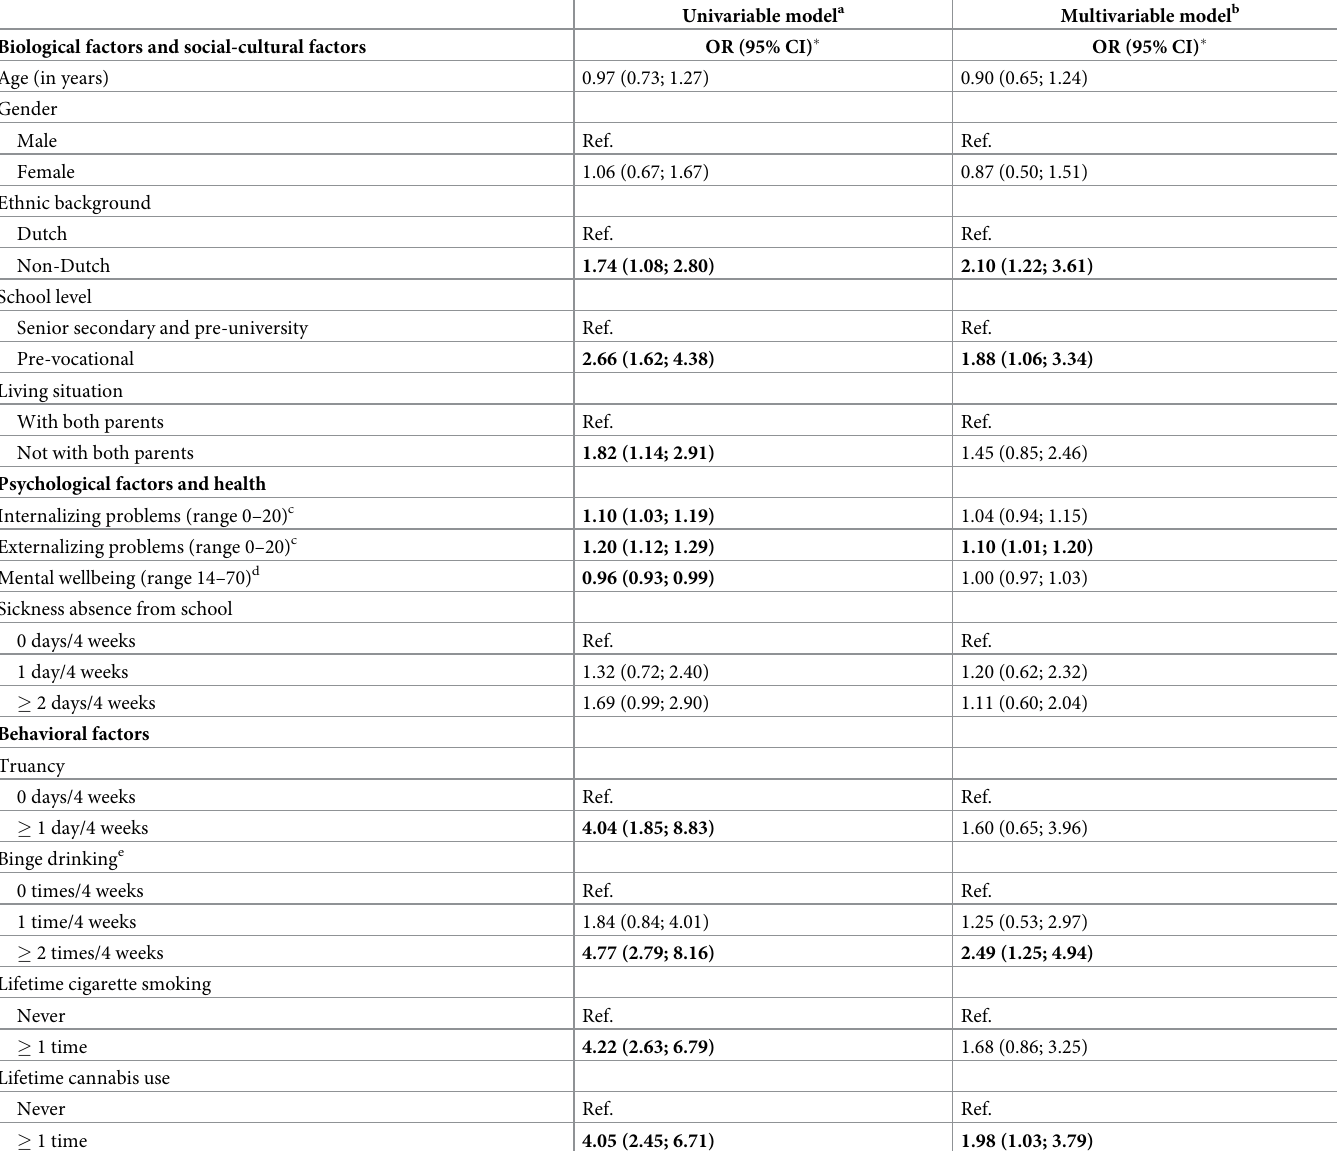
Table 3. Results of the univariable and multivariable ordinal logistic regression analyses evaluating associations of biological factors and social-cultural factors, psy- chological factors and health, and behavioral factors with recreational nitrous oxide